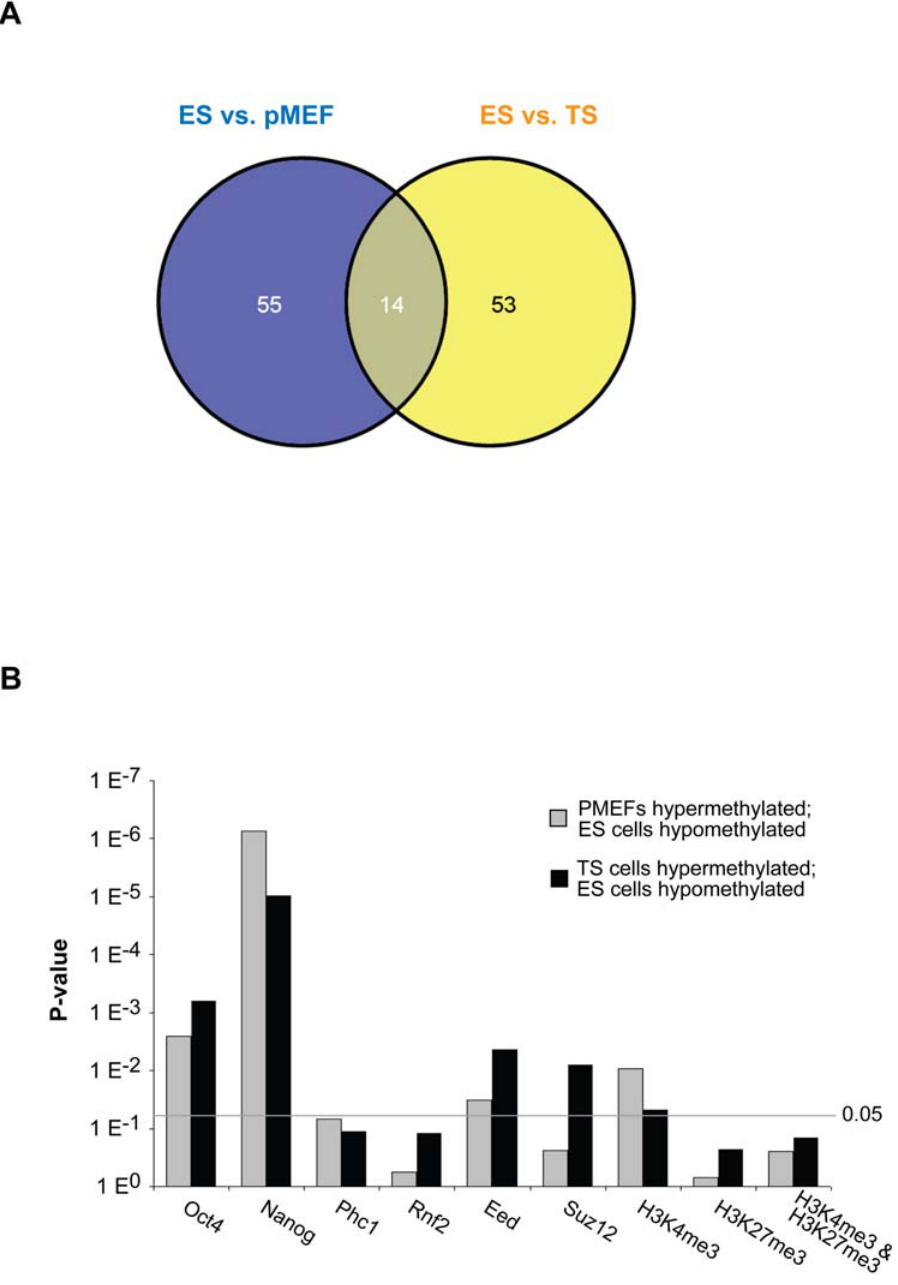
Figure 5. Global comparisons between promoter methylation and chromatin signatures. (A) Venn diagram showing the overlapping genes between ES cell versus pMEFs (blue) and ES cell versus TS cell (yellow) datasets. 14 genes were found in common and show hypermethylation in lineage committed and differentiated cell types. (B) Comparison of differentially methylated genes in the ES cell versus pMEFs or ES cell versus TS cell dataset with ChIP datasets of Nanog/Oct4- and PcG-binding sites [43,45], and histone H3K4/H3K27 methylation [48] in ES cells. Correlations with p-values of , 0.05 are regarded as significant. Genes analyzed were all hypomethylated in ES cells and hypermethylated in pMEFs or TS cells.